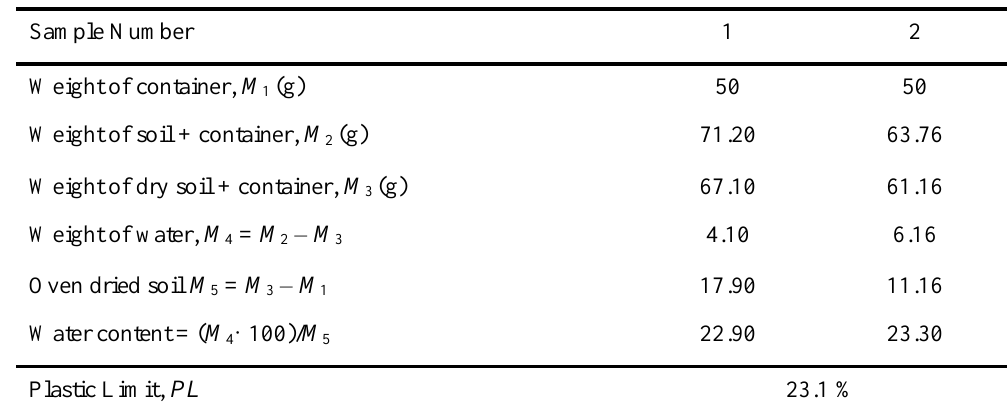
Table 4. Plastic Limit of Laterite Soil (developed by the authors, based on the conducted survey)